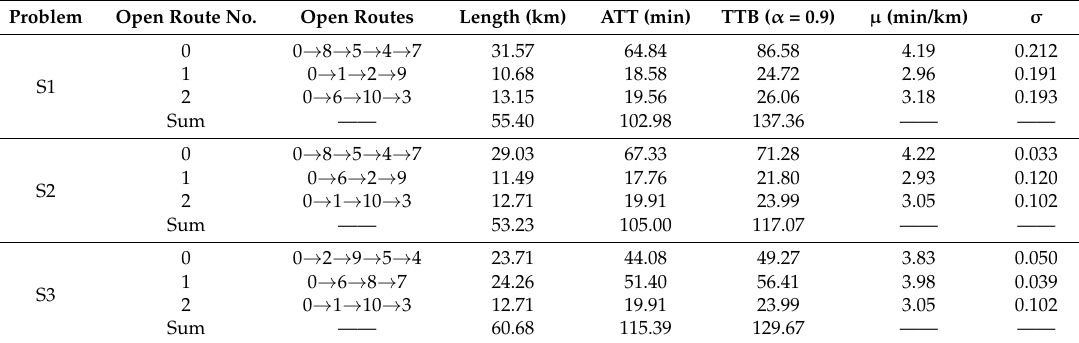
Table 7. Rescue routing plan performance for S1, S2, and S3.